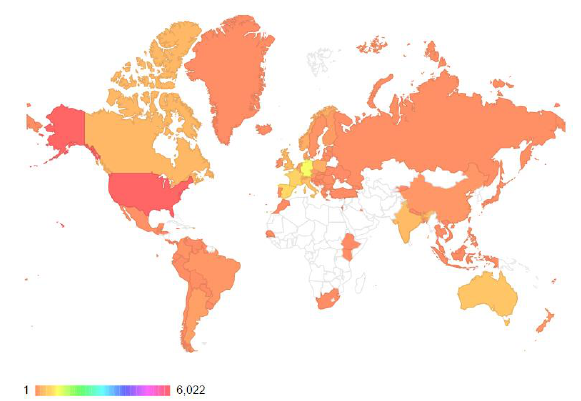
Figure 6. Geographic distribution of available OGC services